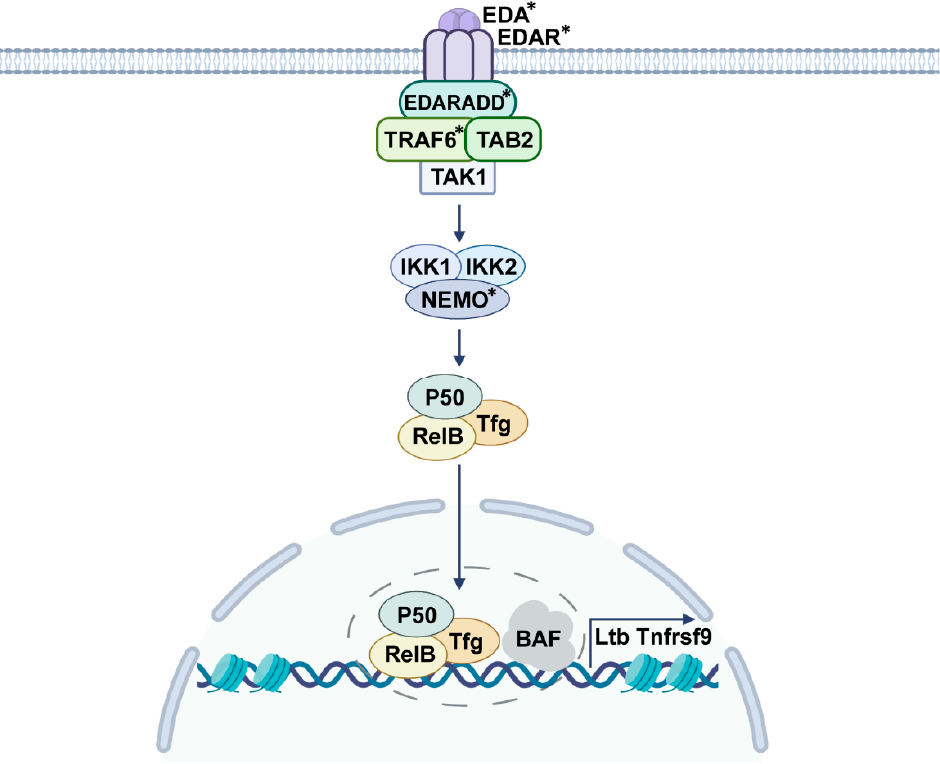
Figure 1. Schematic drawing of the signaling transduction of EDA pathway. Secreted EDA binds to its receptor EDAR and forms a complex with the intracellular EDARADD, then recruits TAK1, TAB2, and TRAF6, induces IKK phosphorylation, and translocates NF- κ B into the nucleus, followed by attaching with the BAF complex, and eventually facilitates specific gene transcription (*: gene mutations identified in HED